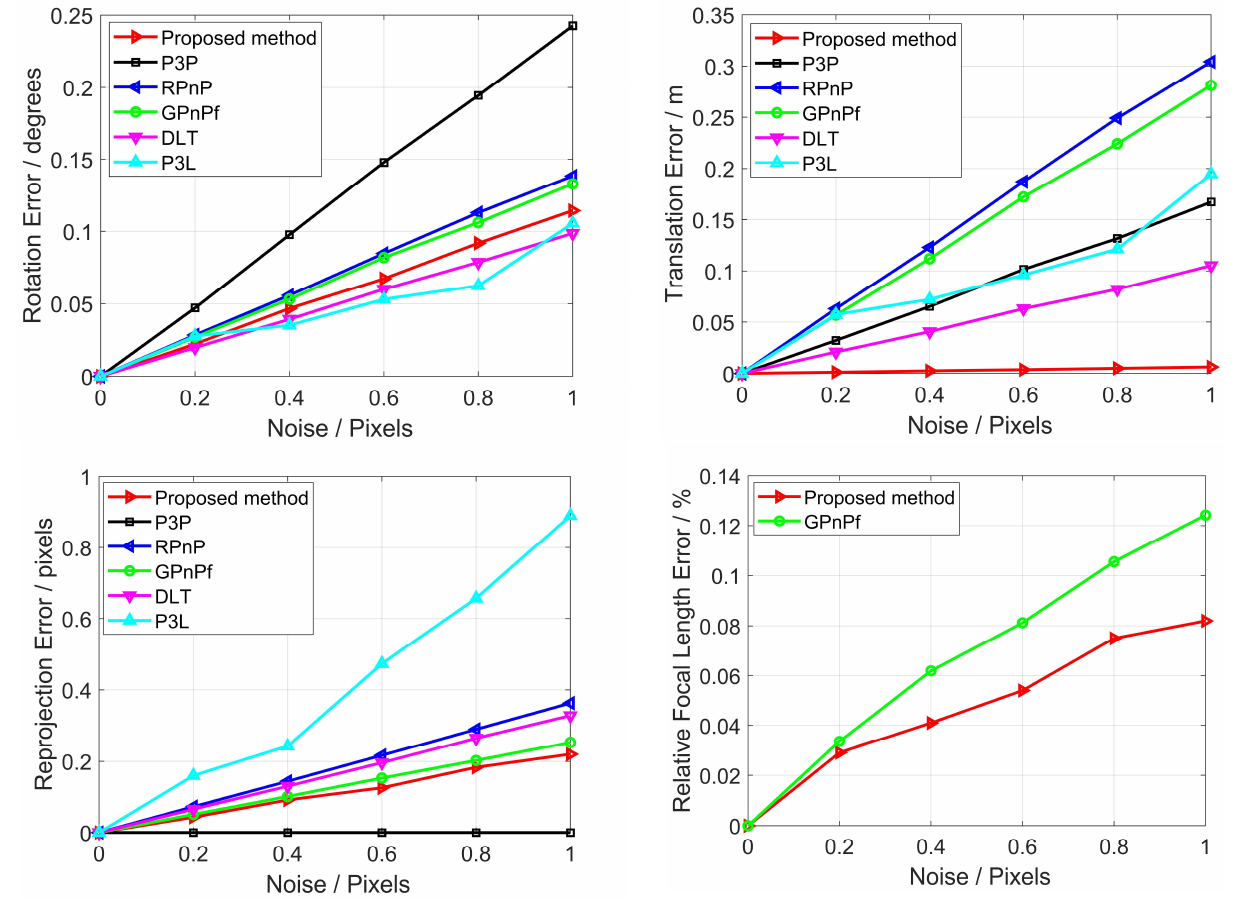
Figure 7. Noise sensitivity for our proposed method (Red), P3P (Black), RPnP (Blue), GPnPf (Green), DLT (Purple) and P3L (Cyan). The top left is the rotation error, the top right is the translation error, the bottom left is the reprojection error, and the bottom right is the focal length error.